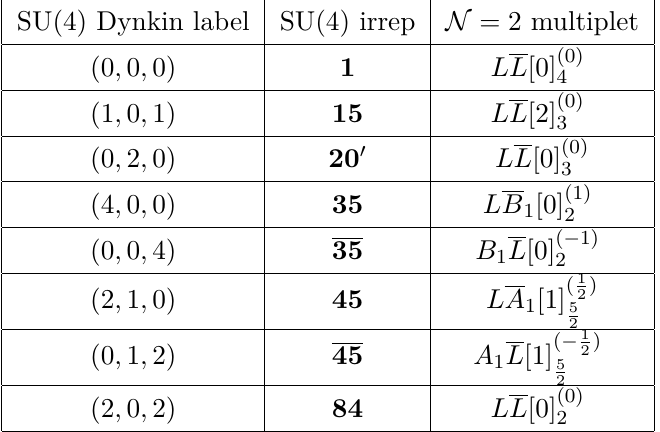
Table 5 . The N = 2 multiplets from KK level n = 2 for the antiperiodic spin structure. N = 2 superconformal multiplets where for level n ≥ 2 the result is given by